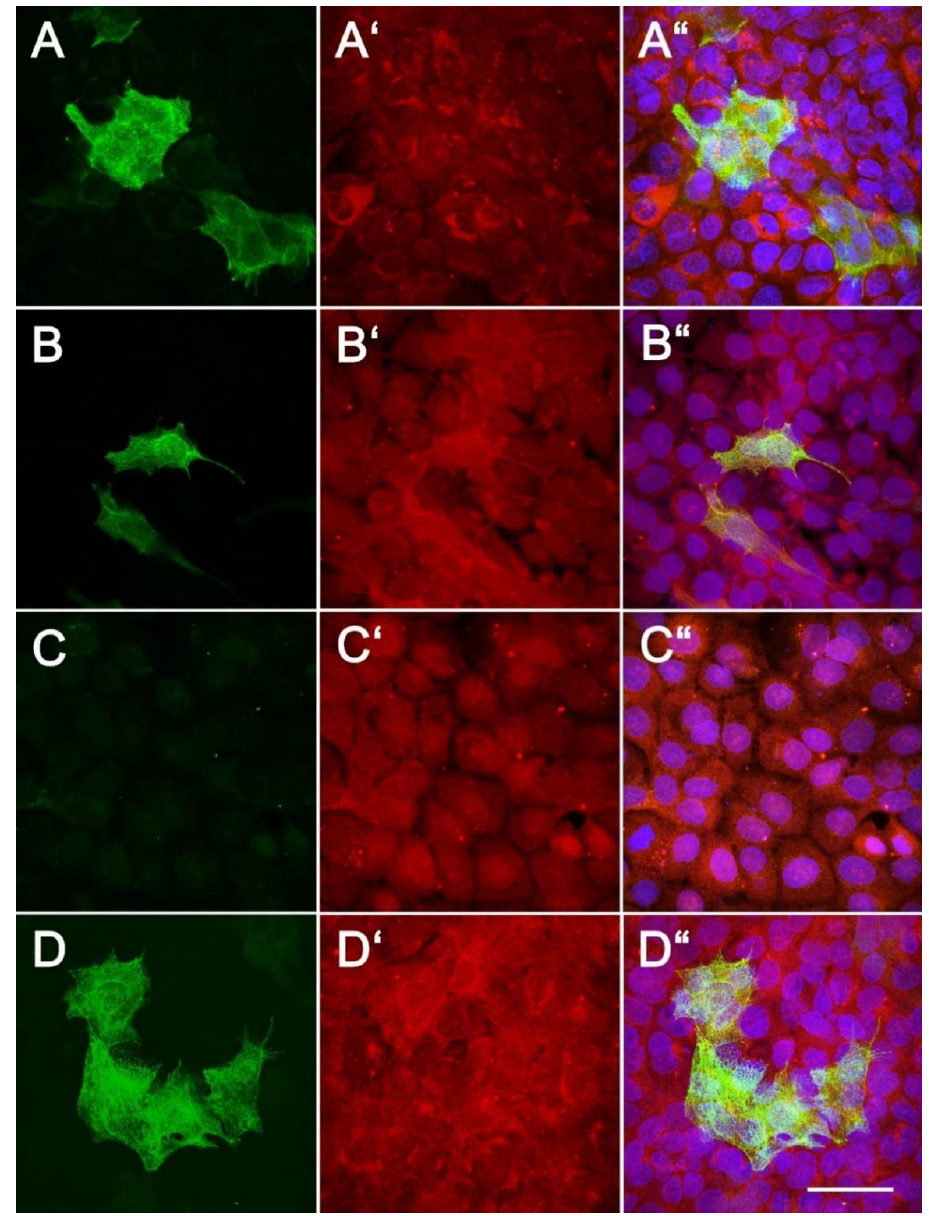
Figure 6. Immunofluorescence staining for cytokeratin 10 (green) ( A , A“ , B , B“ , C , C“ , D , D“ ) and cy- tokeratin 14 (red) ( A‘ , A“ , B‘ , B“ , C‘ , C“ , D‘ , D“ ) of the HaCaT cells following 14 days of culturing. The cell nuclei were counterstained with Hoechst 33258 (blue). The cells were grown on glass in DMEM containing 2% FS without the presence of PL ( A , A‘ , A“ ), in DMEM containing 2% FS and 2.5% PL ( B , B‘ , B“ ), in DMEM containing 2% FS with the presence of pure PVA ( C , C‘ , C“ ), and in DMEM containing 2% FS with the presence of PVA–PL ( D , D‘ , D“ ). Leica SPE confocal microscope, obj. × 63, scale bar = 25 µ